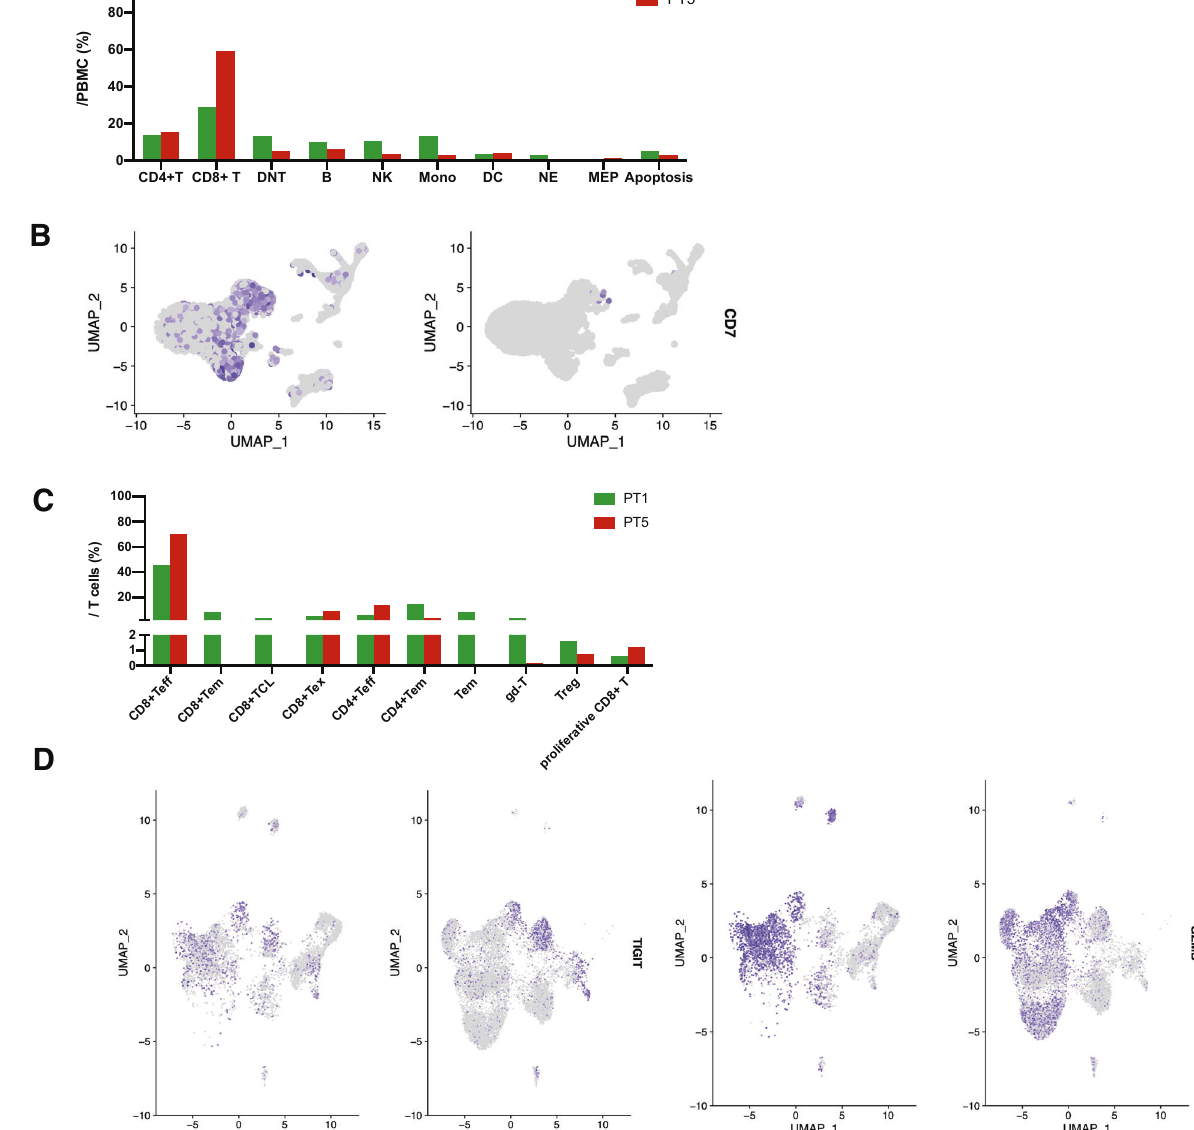
Fig. 5 Single-cell RNA sequencing of patients 1 and 5. A Proportion of various types of cells in peripheral blood mononuclear cells (PBMCs) from patient 1 and patient 5. B Visualize the expression of CD7 in peripheral blood cells by UMAP plots. C Proportion of various types of cells in T cells (PBMCs) from patient 1 and patient 5. D Visualize the expression of TIGHT and GZMA in T cells by UMAP plots. Patient 1 (left), patient 5 CD7 CAR-T cell therapy has been regarded a promising option for patients with R/R T-cell malignancies. DATA AVAILABILITY The original contributions presented in the study are included in the article. The single-cell RNA sequencing analyzed in this study have been uploaded to GEO with an accession number, GSE227828. Further inquiries can be directed to the corresponding authors upon reasonable request.